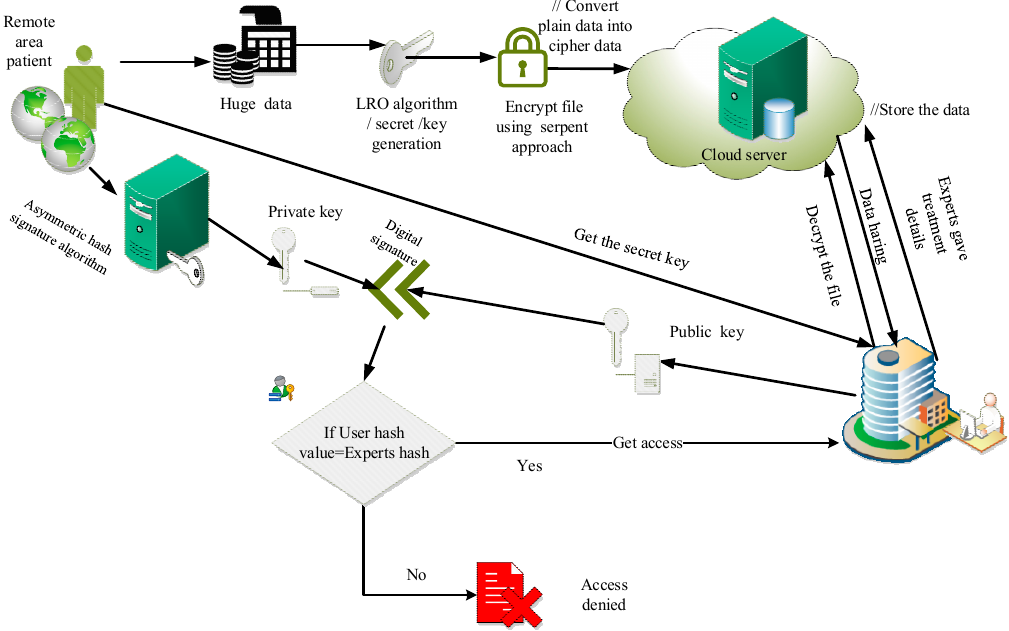
Figure 1. Proposed model of security system in smart hospital management.